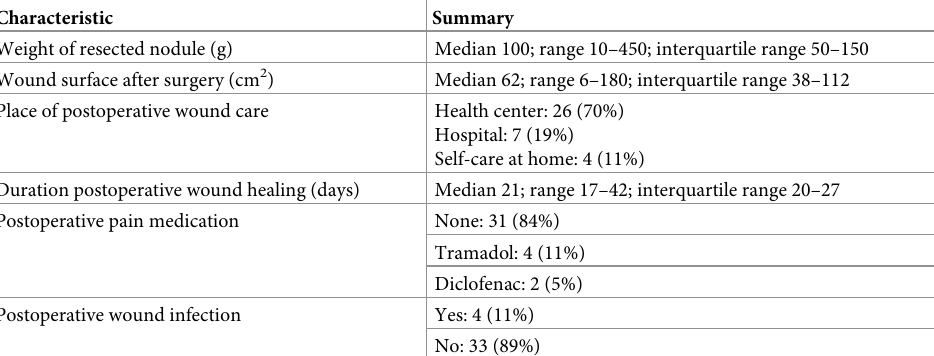
Table 2. Characteristics of surgery and postoperative care after nodulectomy (n = 37) for podoconiosis patientin Bahir Dar, Ethiopia between January 2015 and December 2019.